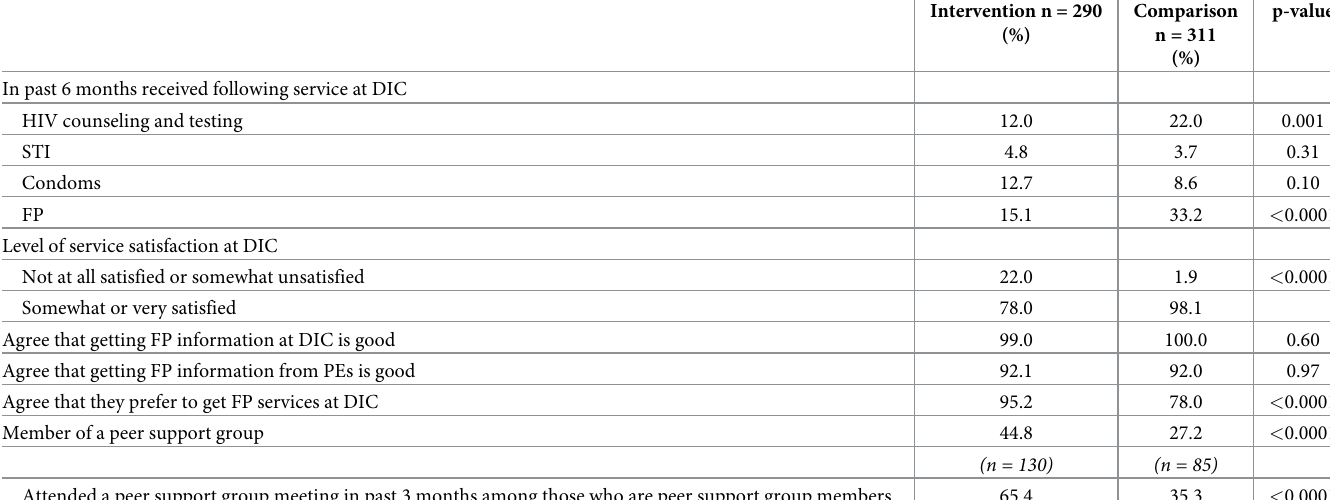
Table 5. Service uptake, satisfaction and acceptability at follow-up (non-imputed data). Chi square test for categorical